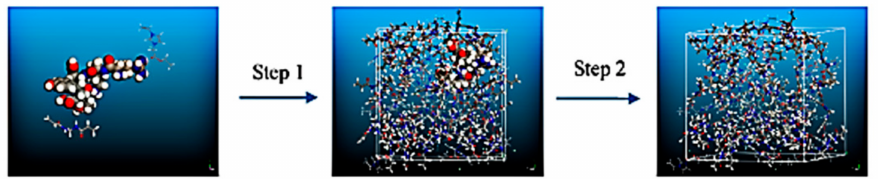
Figure 11. Schematic representation of the molecular imprinting of thymopentin. Specific binding cavities are generated using IL as the functional monomer [93]. Reprinted with permission of